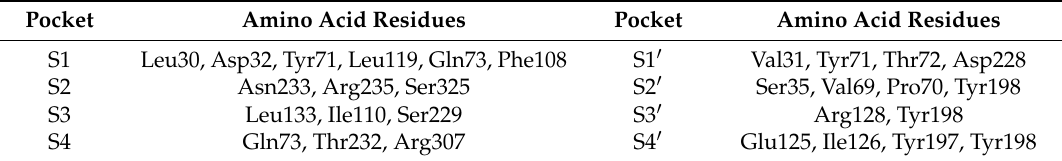
Table 4. Pockets and their amino acid residues on the catalytic domain of BACE-1